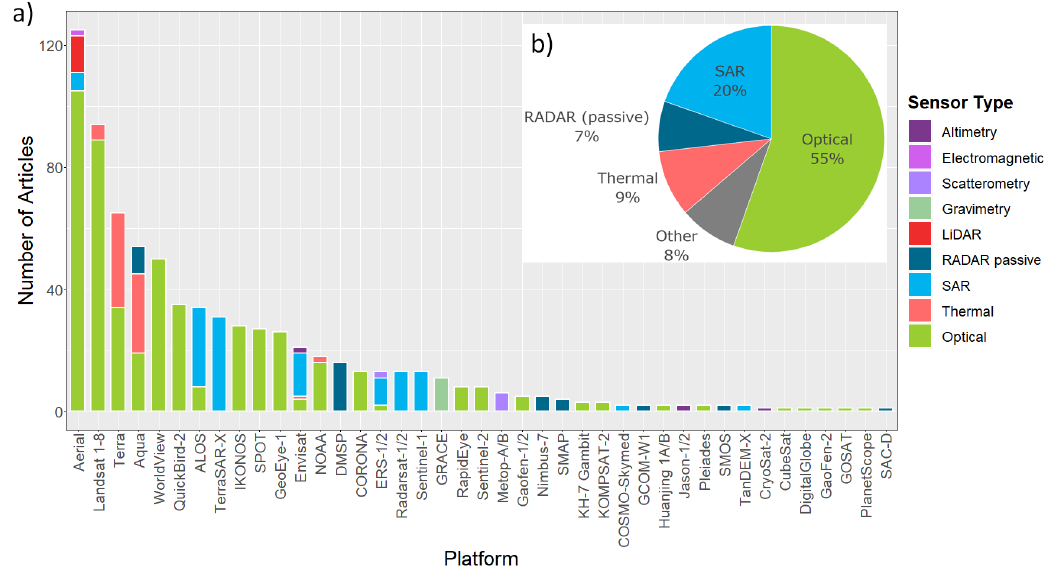
Figure 13. Remote sensing platforms utilized within the reviewed articles ( a ). Several platforms carry multiple sensors. The frequency of applied sensor types is therefore shown for each platform ( a ) as well as the overall distribution of sensor types ( b ). “Aerial” was also considered for the platform frequency analysis since many articles employed aerial imagery either as a historical reference, for validation or other complementary use with satellite data and is therefore included for